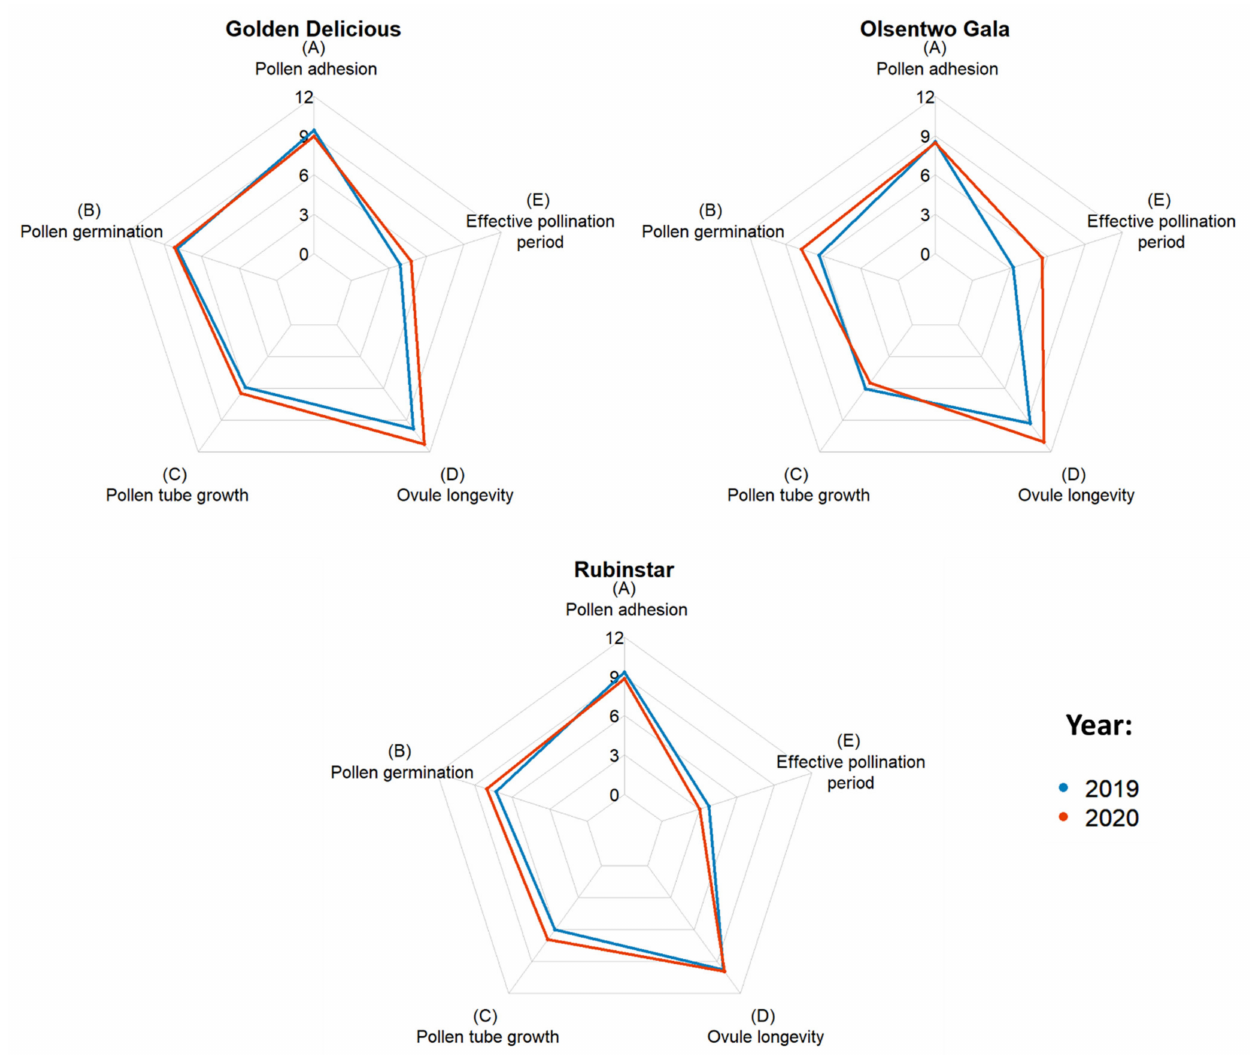
Figure 1. Duration of stigmatic receptivity based on pollen adhesion ( A ), and pollen germination ( B ), pollen tube growth from stigma to ovule ( C ), ovule longevity ( D ) and effective pollination period ( E ) of ‘Golden Delicious’, Olsentwo Gala’, and ‘Rubinstar’ flowers in 2019 (blue) and 2020